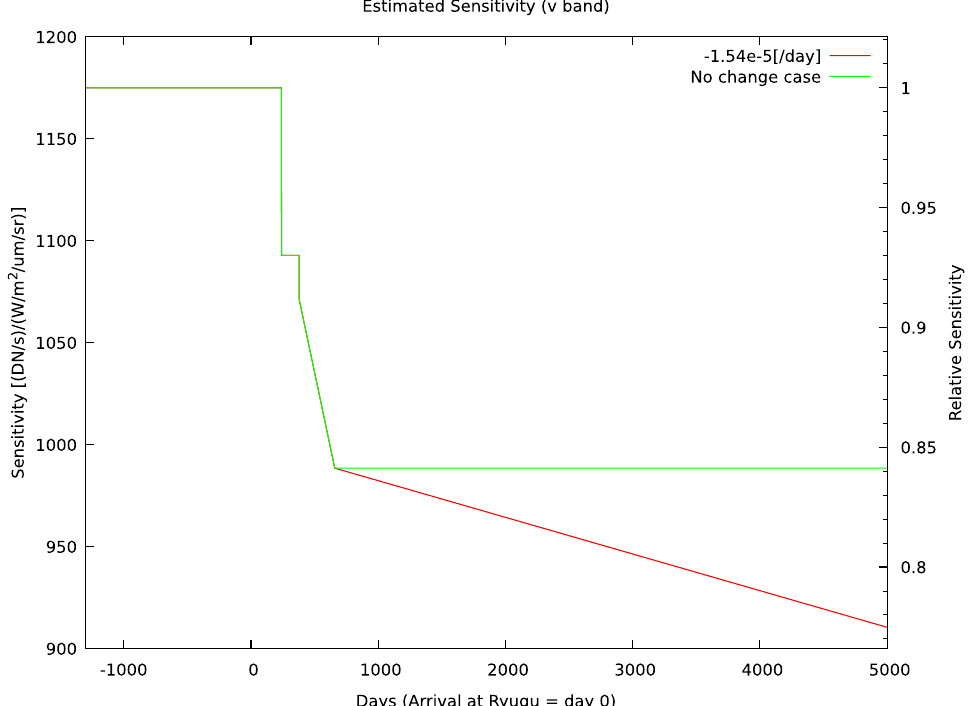
Fig. 13 Model of sensitivity changes for ONC-T in the v band. Changes up to April 15, 2020 are from stellar observations (Table 3). After that, the red line shows the case with a sensitivity decrease, and the green line shows the case with no